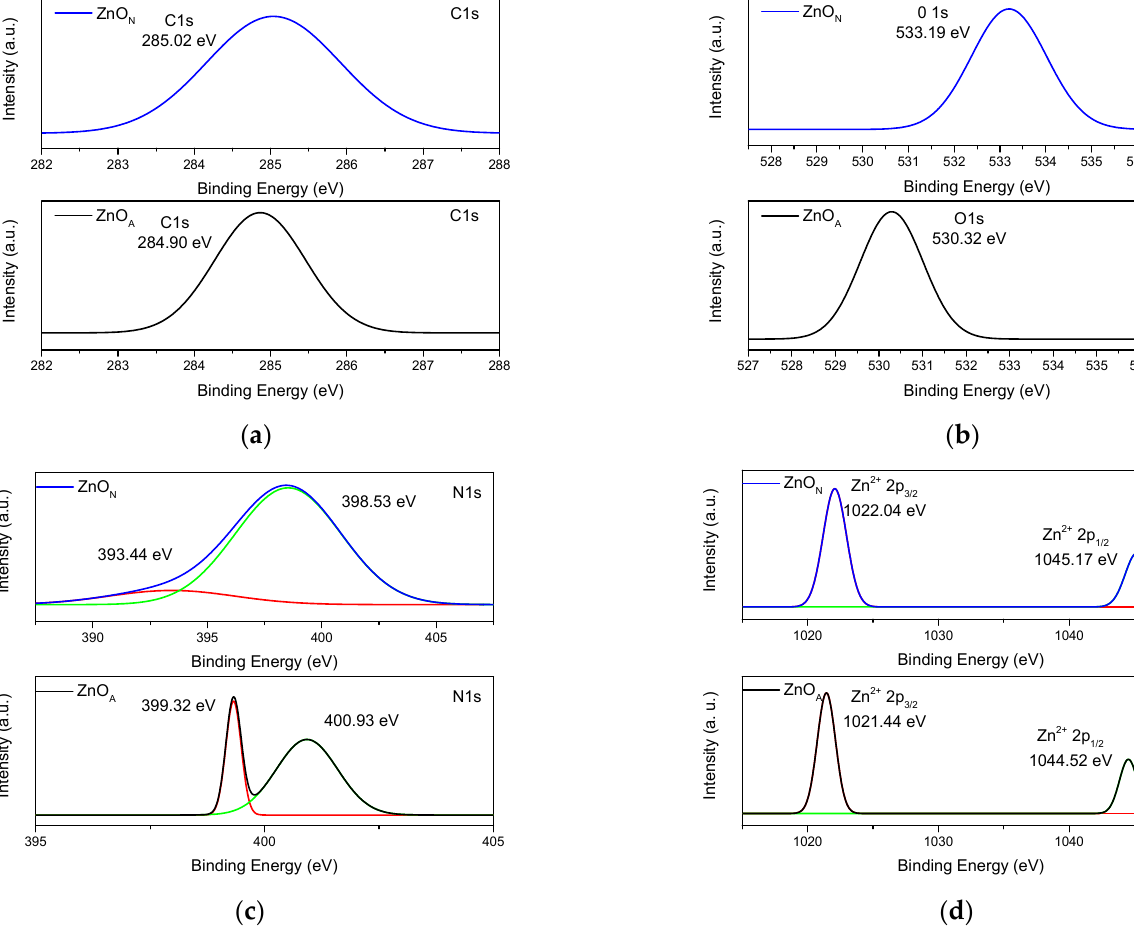
Figure 7. XPS spectra of nanomaterials: C1s ( a ), O1s ( b ), N1s ( c ) and Zn2p ( d ) with ZnO N and ZnO A respectively. Table 2. Atomic surface composition determined by XPS.